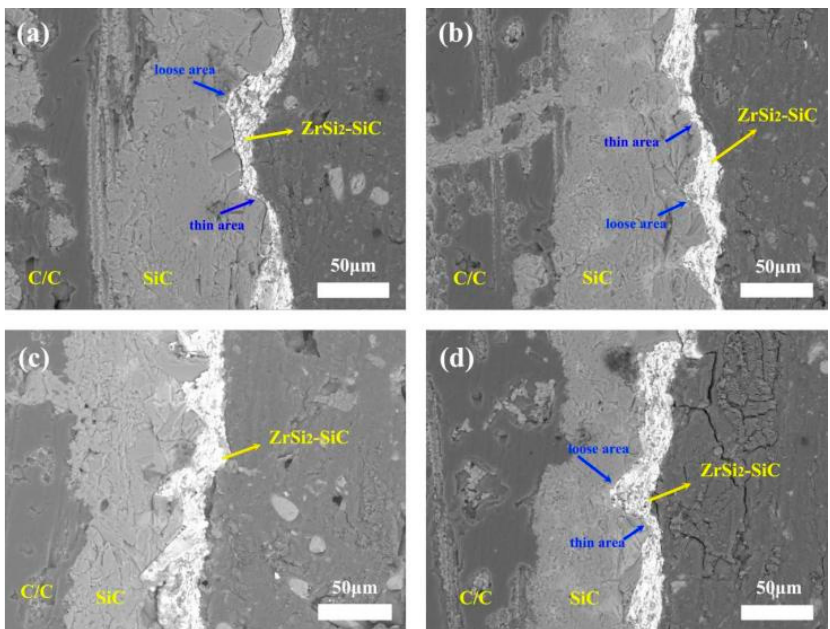
Figure 5. The SEM images of the cross section of the four kinds of ZrSi 2 -SiC coatings with different ZrSi 2 contents. ( a ) 10 wt.% ZrSi 2 -90 wt.% SiC; ( b ) 20 wt.% ZrSi 2 -80 wt.% SiC; ( c ) 30 wt.% ZrSi 2 -70 wt.% SiC; ( d ) 40 wt.% ZrSi 2 -60 wt.% SiC.